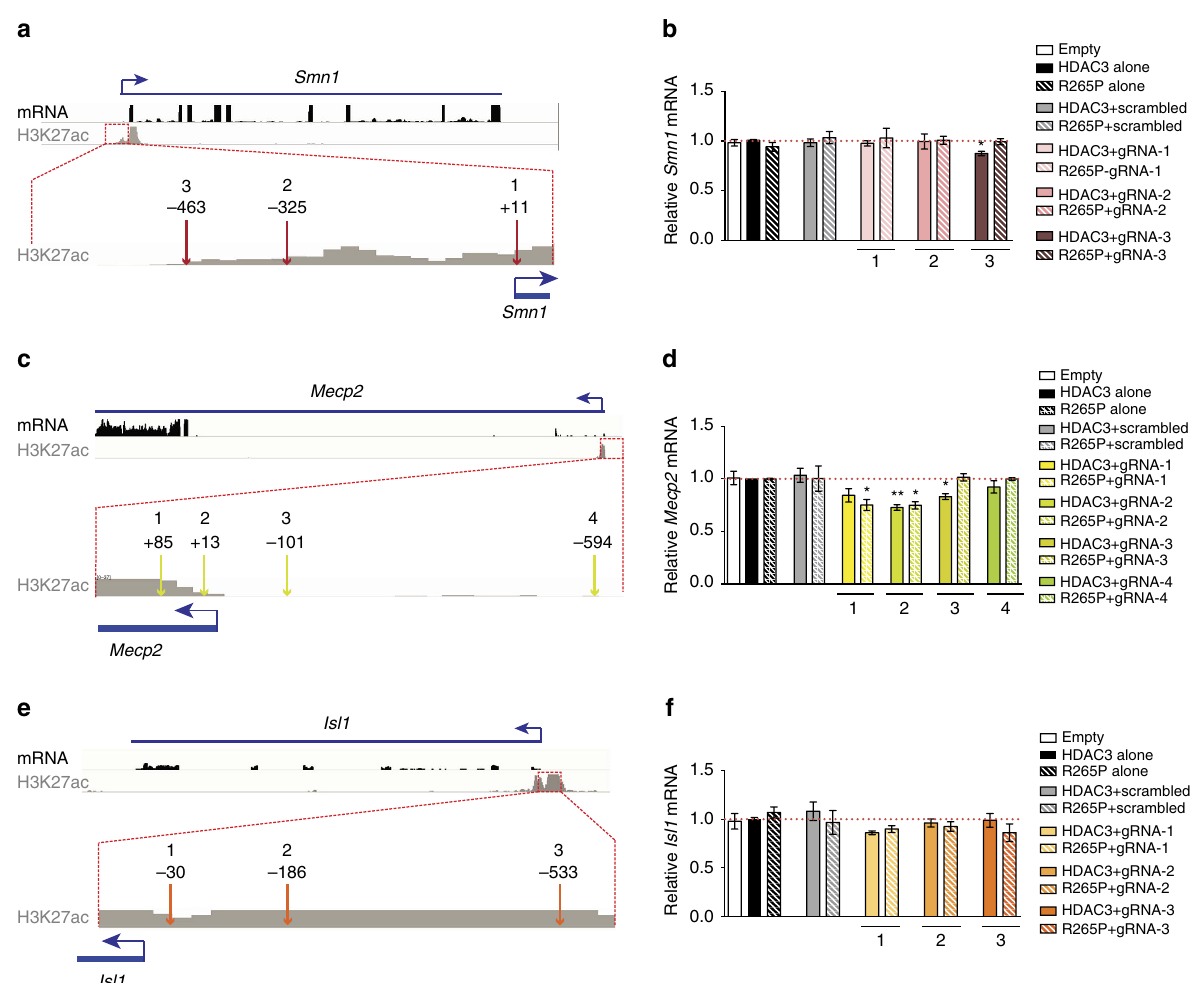
Figure 2 | Positional effects of dCas9-HDAC3 on gene expression at three different loci. ( a ) RNA-seq and H3K27ac ChIP-seq reads mapped to a region encompassing the murine Smn1 gene. Magnified insets of H3K27ac enrichment at the Smn1 promoter locus with approximate locations of each gRNA-targeted site are displayed below. ( b ) Quantitative RT–PCR measurements of relative mRNA levels of Smn1 from N2a cells co-transfected with each gRNA and the indicated dCas9 proteins (relative to cells transfected with dCas9-HDAC3 alone; red dashed line) * P o 0.05; n ¼ 7 biological replicates; error bars, s.e.m. ( c ) Schematic depiction of a region encompassing the murine Mecp2 gene showing RNA-seq and H3K27ac tracks. Magnified insets of H3K27ac enrichment at the promoter locus with approximate locations of each gRNA-targeted site are displayed below. ( d ) RT–PCR measurements of mRNA levels of Mecp2 from N2a cells co-transfected with each gRNA and the indicated dCas9 proteins (relative to cells transfected with dCas9-HDAC3 alone; red dashed line) * P o 0.05; ** P o 0.01; n ¼ 7 biological replicates; error bars, s.e.m. ( e ) RNA-seq and H3K27ac ChIP-seq reads mapped to a genomic region encompassing murine Isl1 . Magnified insets of H3K27ac enrichment at the Isl1 promoter locus with approximate locations of each gRNA-targeted site are displayed below. ( f ) RT–PCR measurements of mRNA levels of Isl1 from N2a cells co-transfected with each gRNA and the indicated dCas9 proteins (relative to cells transfected with dCas9-HDAC3 alone; red dashed line) n ¼ 10 biological replicates; error bars, s.e.m. All data were analysed using one-way ANOVA with Dunnett